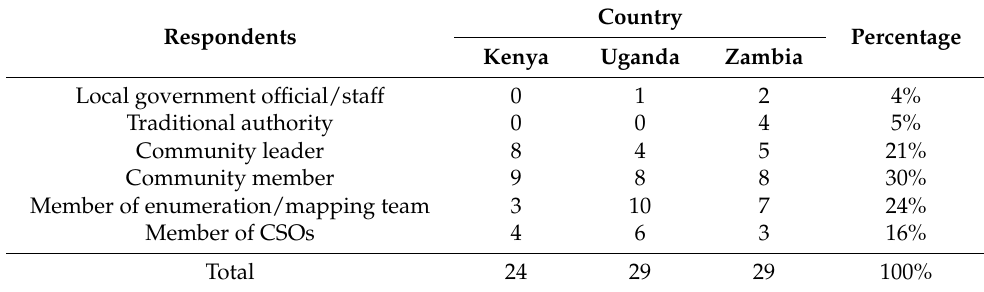
Table 1. Respondents for the primary data